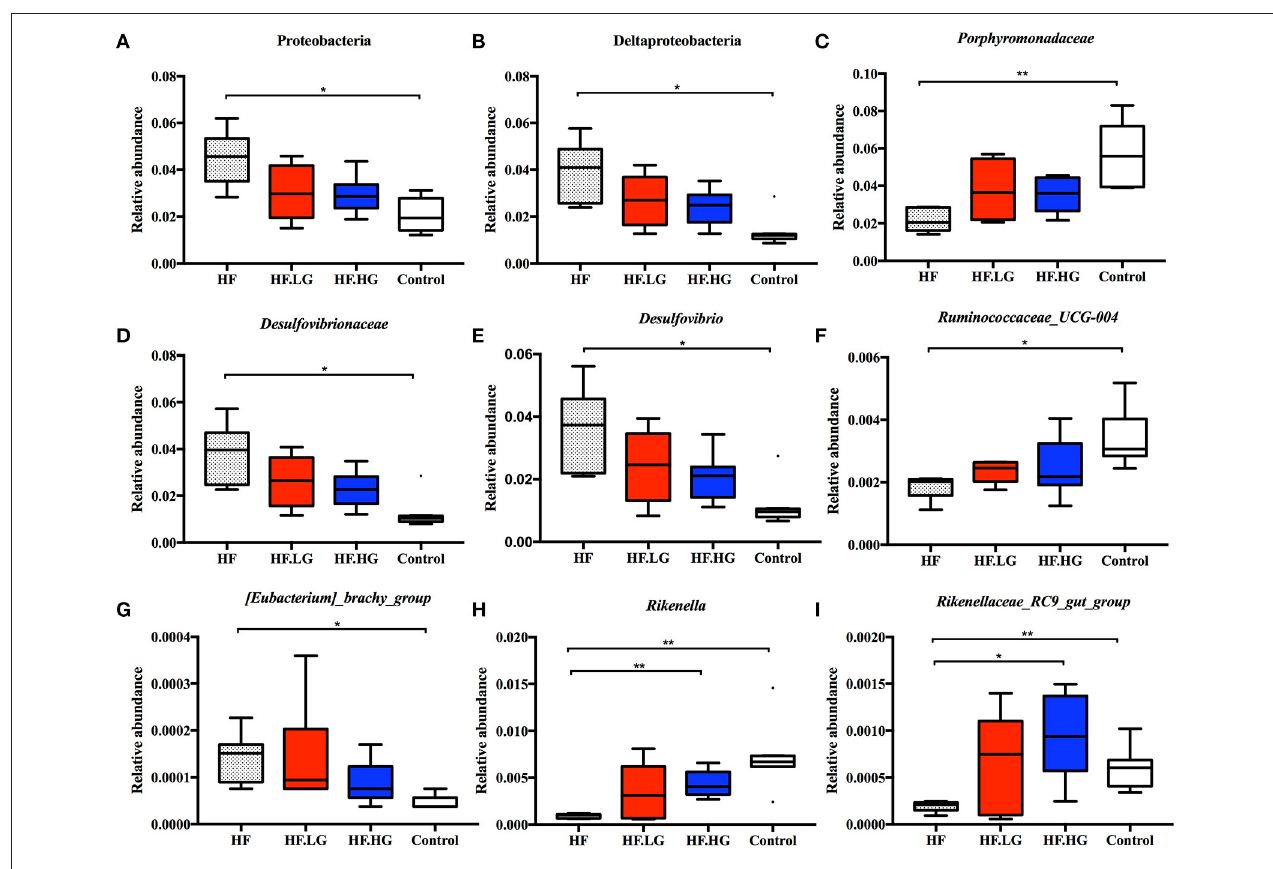
FIGURE 6 | Relative abundance of bacterial taxa at different taxonomic levels in each group. ( n = 6–8/group). (A) Proteobacteria; (B) Deltaproteobacteria; (C) Porphyromonadaceae ; (D) Desulfovibrionaceae ; (E) Desulfovibrio ; (F) Ruminococcaceae_UCG-004 ; (G) [Eubacterium]_brachy_group ; (H) Rikenella ; and (I) Rikenellaceae_RC9_gut_group . HF, high-fat diet without genistein; HF. LG, high-fat diet with low-dose genistein; HF. HG, high-fat diet with high-dose genistein; Control, normal control diet. Data was analyzed by MetaStat. Mean values were significantly different between other group and the HF group: * q < 0.05, ** q <